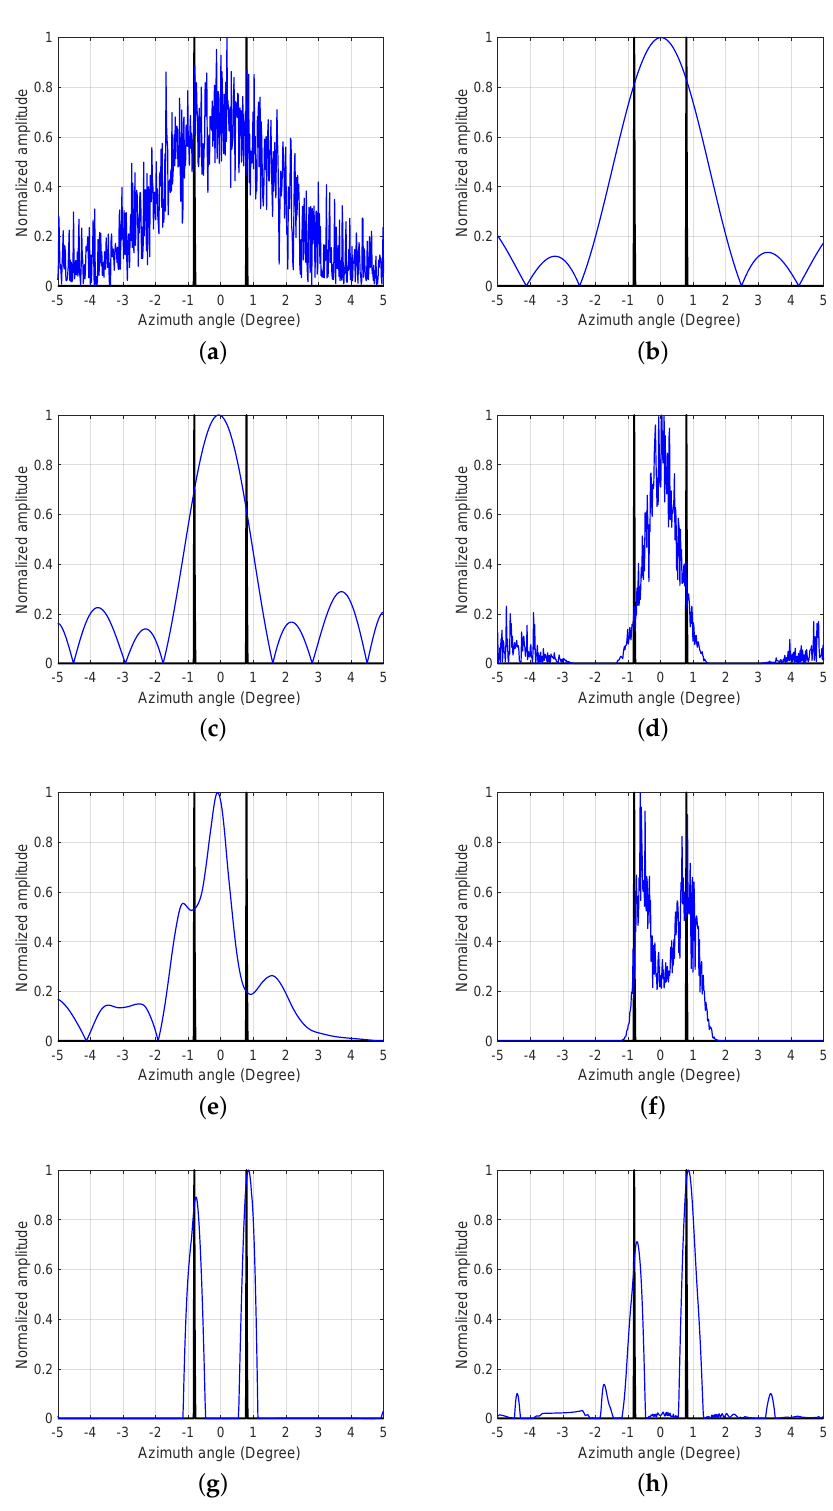
Figure 3. Point targets simulation results with the SNR of 10 dB. ( a ) Real-aperture echo. ( b ) Result processed by TSVDM. ( c ) Result processed by FTVM. ( d ) Result processed by MLE. ( e ) Result processed by IAA. ( f ) Result processed by MAPE. ( g ) Result processed by SSM. ( h ) Result processed by